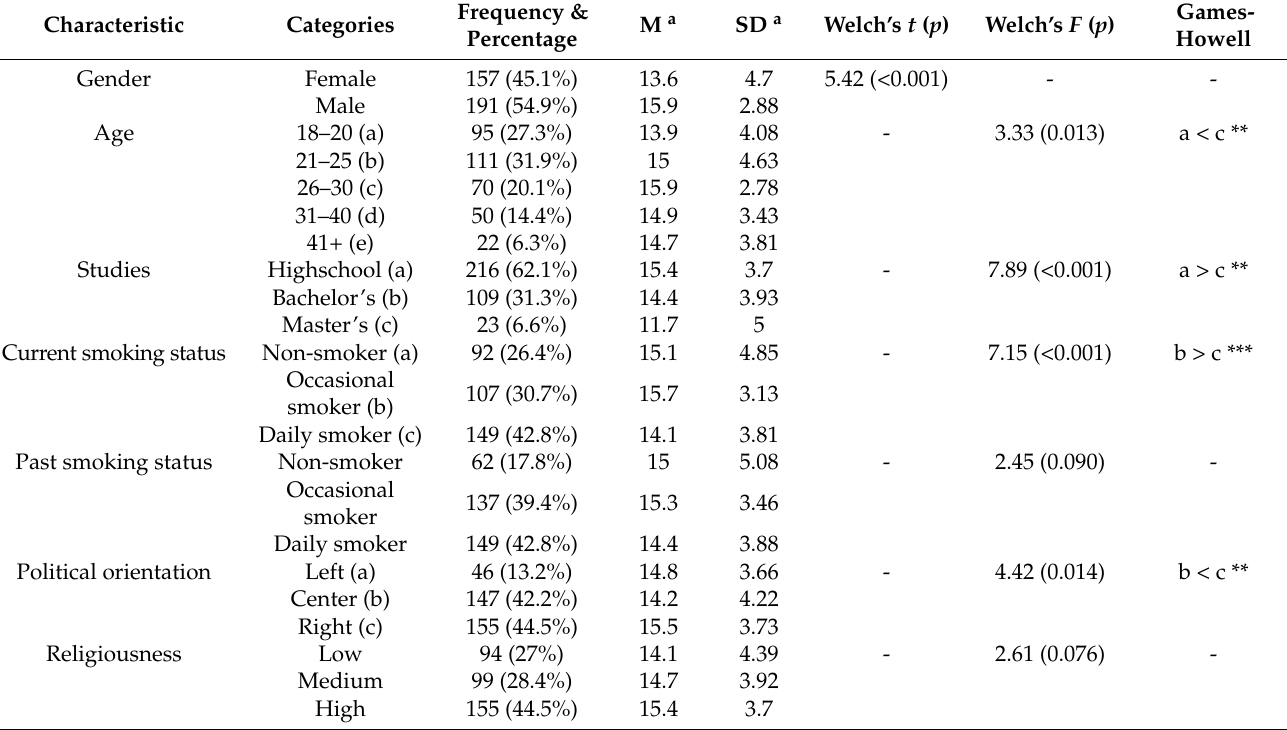
Table 2. Participants’ characteristics and differences in moralization of